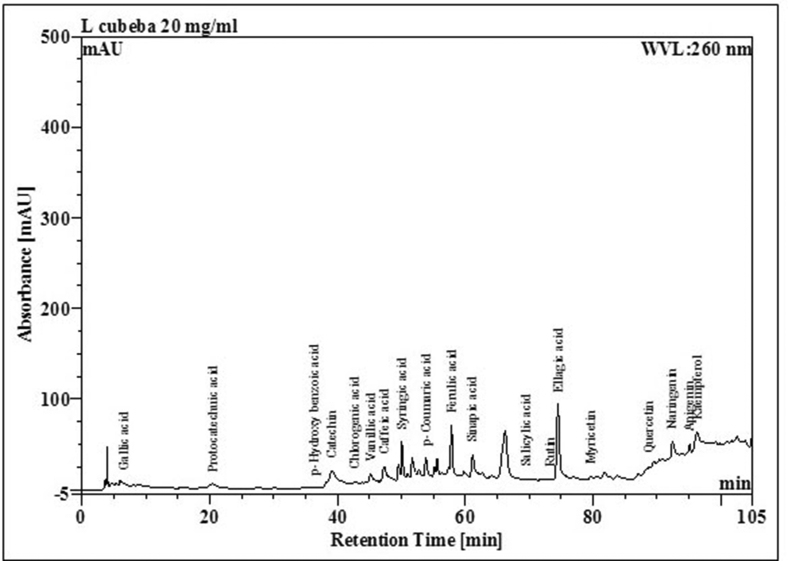
HPLC chromatogram of the methanol extract of the fruits of L. cubeba showing phenolic acids and flavonoids.